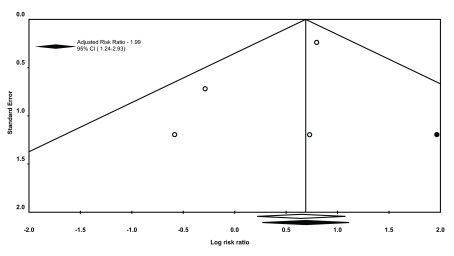
Filled funnel plot using the trim and fill method for risk of respiratory complications: imputed studies - ●, observed studies - ○,
CI – confidence interval.